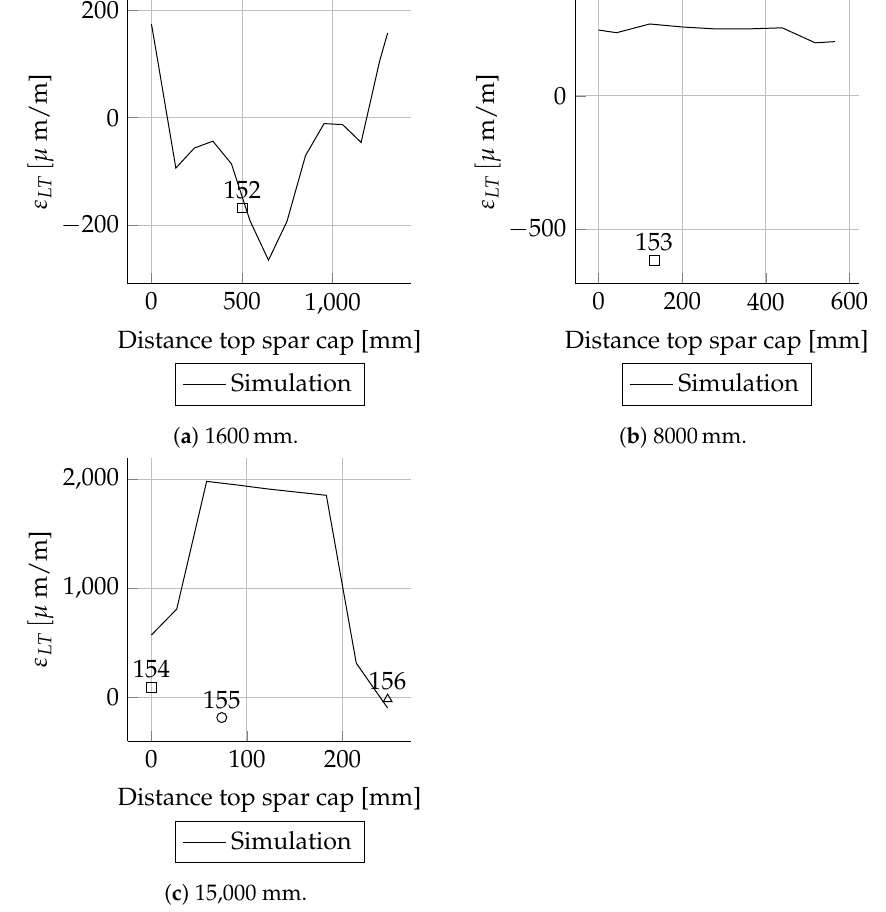
Figure A40. Spar at shear strains for MyMax load case.